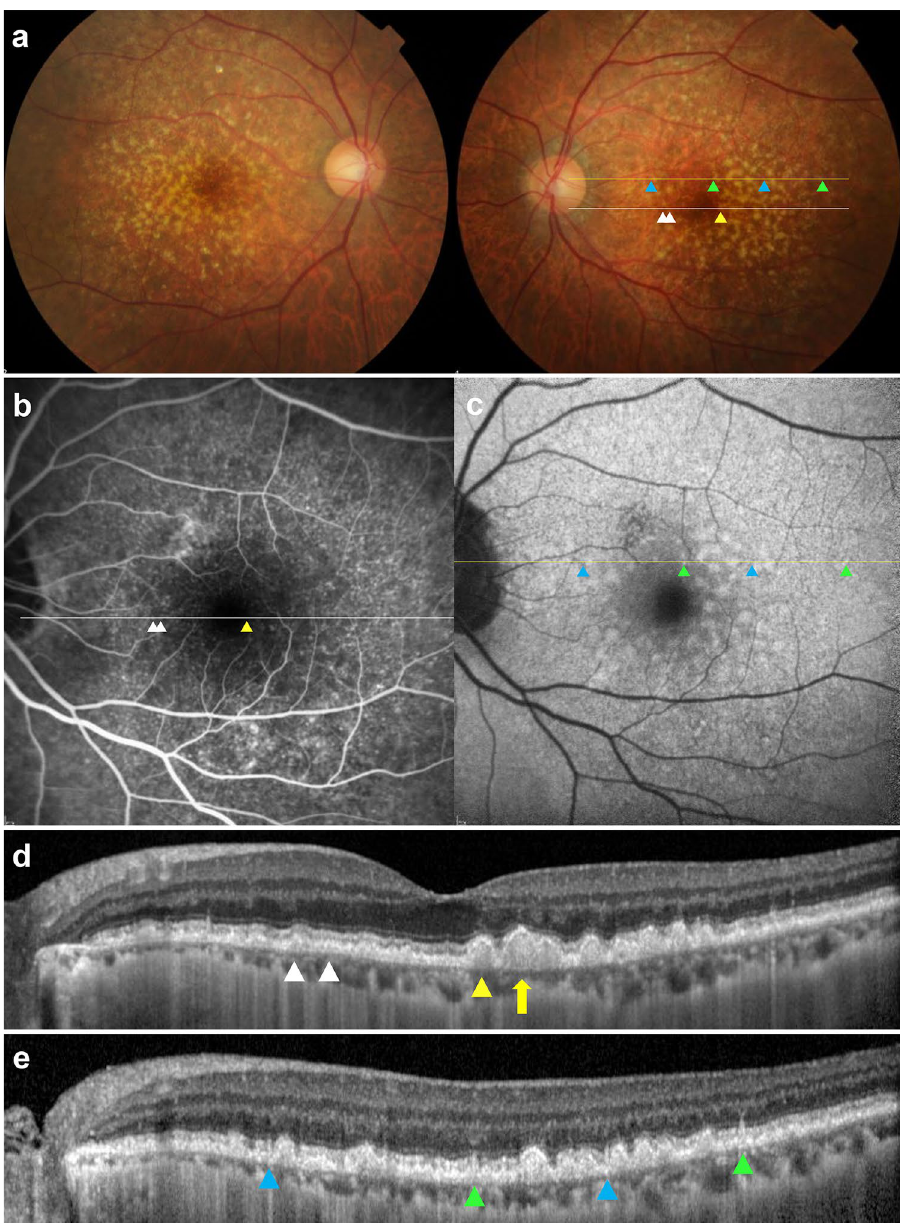
Figure 2. Multimodal Imagings of a 75-year-old woman (Case 2). ( a ) Color fundus photograph shows small to large deposits at the posterior pole in both eyes. ( b ) Fluorescein angiography (FA) of the venous phase shows numerous hyperfluorescent spots, and ( c ) fundus autofluorescence shows numerous hypoautofluorescent centers surrounded by hyperautofluorescent rings. ( d ) Optical coherence tomography (OCT) scan (white line in A and B) shows saw-tooth elevation of retinal pigment epithelium (RPE) at the position of hyperfluorescent spots in FA, corresponding to culticular drusen (white arrowhead). Yellow arrowhead indicates sub-RPE deposit with no hyperfluorescence in FA (soft drusen). Large drusen (> 200 μm) is also observed (yellow arrow). ( e ) OCT scan at the location of the yellow line in A and C shows subretinal deposits, corresponding to reticular pseudodrusen (blue arrowhead) and variant subretinal drusenoid deposits (green